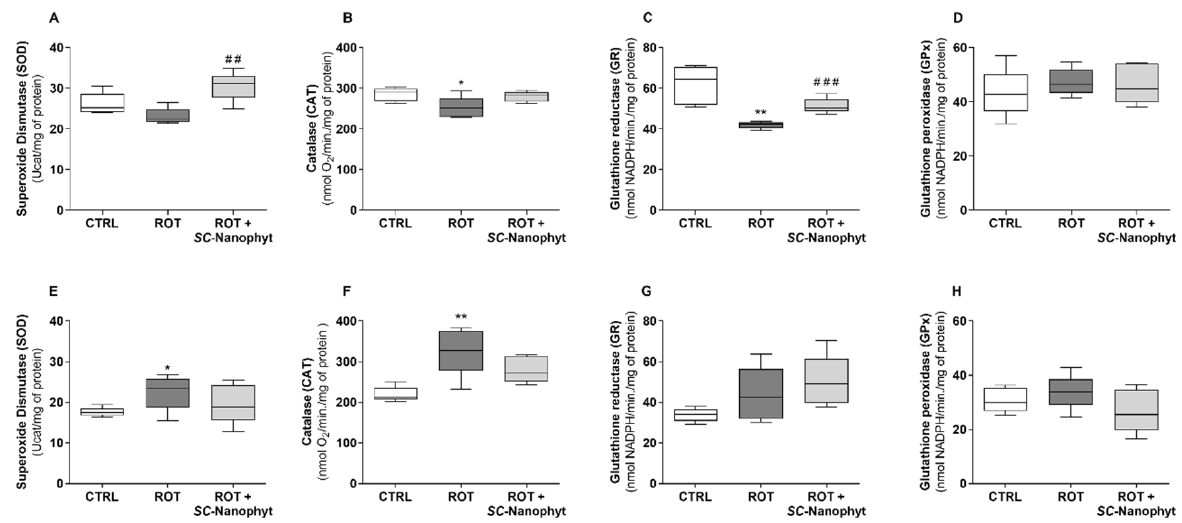
Figure 9. SOD ( A , E ), CAT ( B , F ), GR ( C , G ) and GPx ( D , H ) activity in the mitochondria-free cytosolic fraction from BG-Cereb ( A – D ) and C-Cortex ( E – H ) brain portions of CTRL, ROT and ROT + SC - Nanophyt groups. Error bars represent SEM for n = 5 independent experiments using five animals in each one. *, ** Significantly different from CTRL group, with p ≤ 0.05 and p < 0.01, respectively. ## , ### Significantly different from ROT group, with p < 0.01 and p < 0.001,